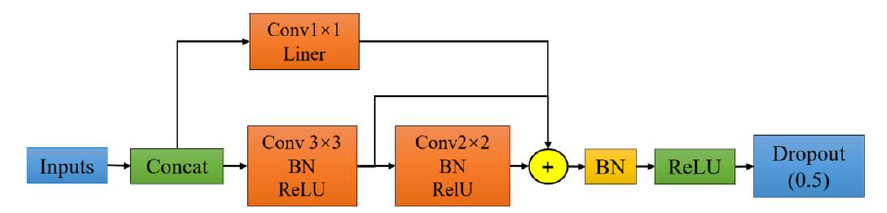
Figure 3. The improved residual block.